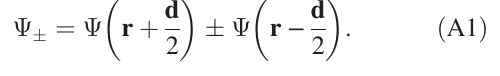
4 and (b) k 1 . c ¼ c ¼ d Þ c